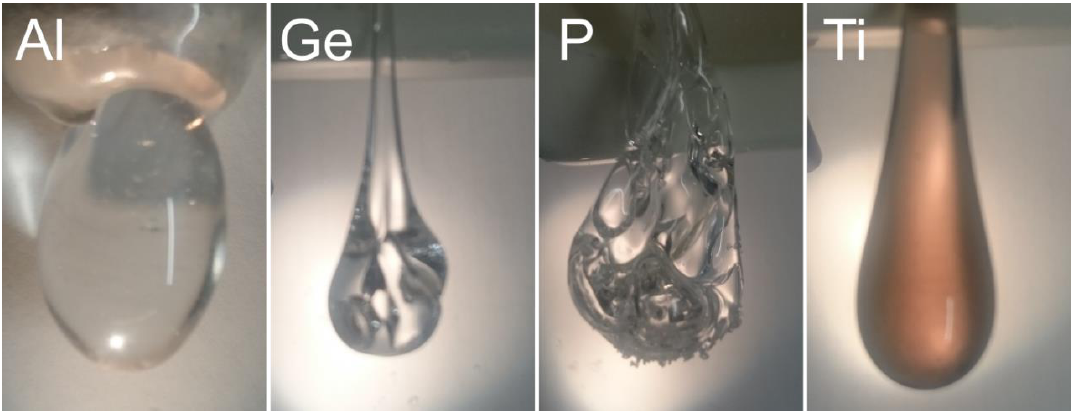
Figure 17. Optical passively separately doped Al, Ge, P and Ti droplets confirm the proof of principle for the sol-gel-based granulated silica method. The different shapes can be explained by a change of melting temperature depending on the dopant (the preforms were drawn at a fix temperature above 1900 °C) [7].